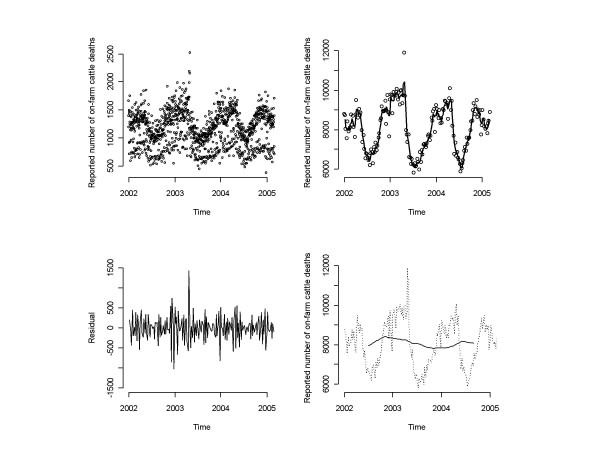
Time series for "on-farm" cattle deaths reported to BCMS over the period 1st Jan 2002 and 28th Feb 2005. (a) Raw data plotted at daily intervals (b) 3-point moving average (raw weekly data shown as unconnected symbols) (c) Residuals after accounting for the 3-point moving average (d) 53-point moving average (raw weekly data shown as unconnected symbols).